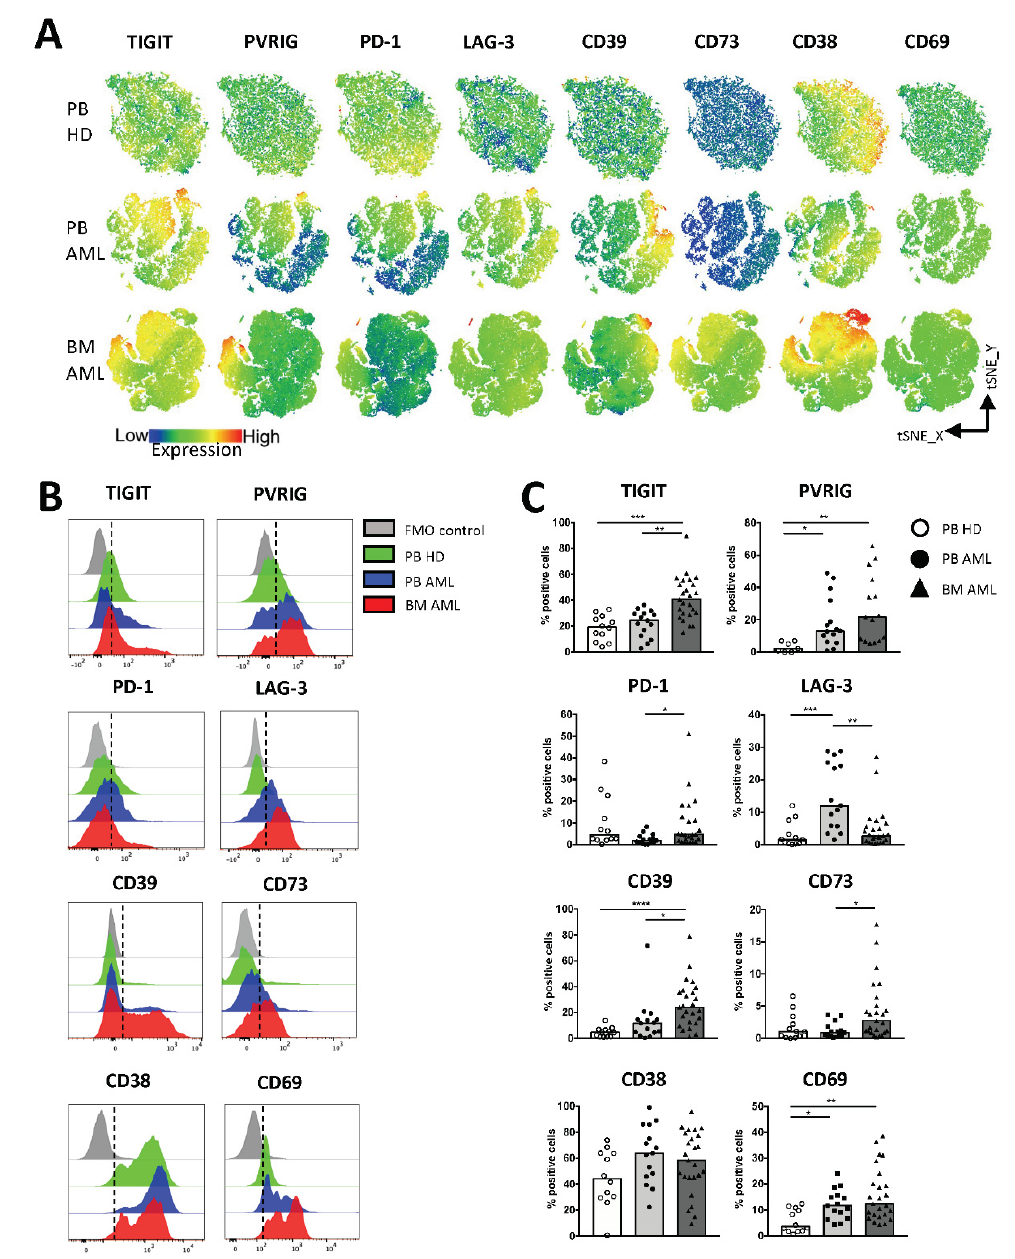
Figure 2. NK cells in AML highly express TIGIT, PVRIG, CD39, and CD69. The expression of TIGIT, PVRIG, PD-1, LAG-3, CD39, CD73, CD38, and CD69 was analyzed in the peripheral blood (PB, n = 15) and bone marrow (BM, n = 25, except for PVRIG n = 15 due to a converted multiparameter flow cytometry (MFC) panel) aspirates from patients with AML and compared with the PB ( n = 12, for PVRIG n = 7) from healthy donors (HDs). ( A ) The distribution of TIGIT, PVRIG, PD-1, LAG-3, CD39, CD73, CD38, and CD69 on NK cells is depicted in tSNE heat maps analyzed for PB specimens of 4 HDs (upper graphs), 4 PB specimens of AML patients (middle graphs), and 4 BM aspirates of AML patients (lower graphs). ( B ) Representative flow cytometry plots showing the surface expression of the checkpoint molecules on NK cells from HDs (green histogram), PB-derived NK cells from AML patients (blue histogram), and BM-derived NK cells from AML patients (red histogram) versus the fluorescence minus one control (FMO, gray histogram). ( C ) Summary data illustrating the frequency of TIGIT + , PVRIG + , PD-1 + , LAG-3 + , CD39 + , CD73 + , CD38 + , and CD69 + NK cells from the PB of HDs in comparison to the PB and BM aspirates of AML patients. p values were obtained by the ANOVA and Kruskal–Wallis test. * p < 0.05, ** p < 0.01, *** p < 0.001, **** p < 0.0001.